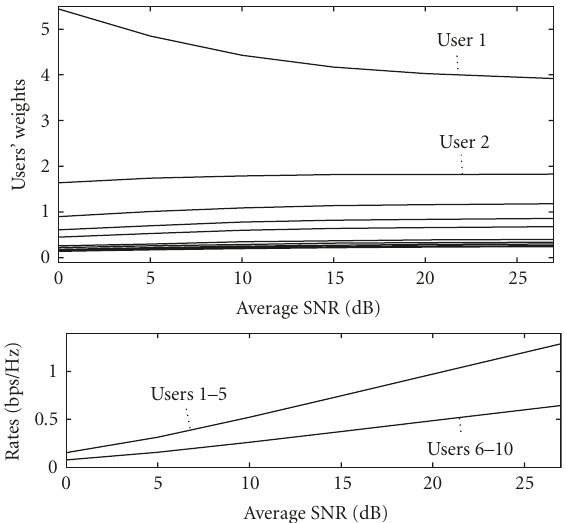
Figure 7: Optimum weights and achievable rates for the two groups of users. The first five curves correspond to the first five users.